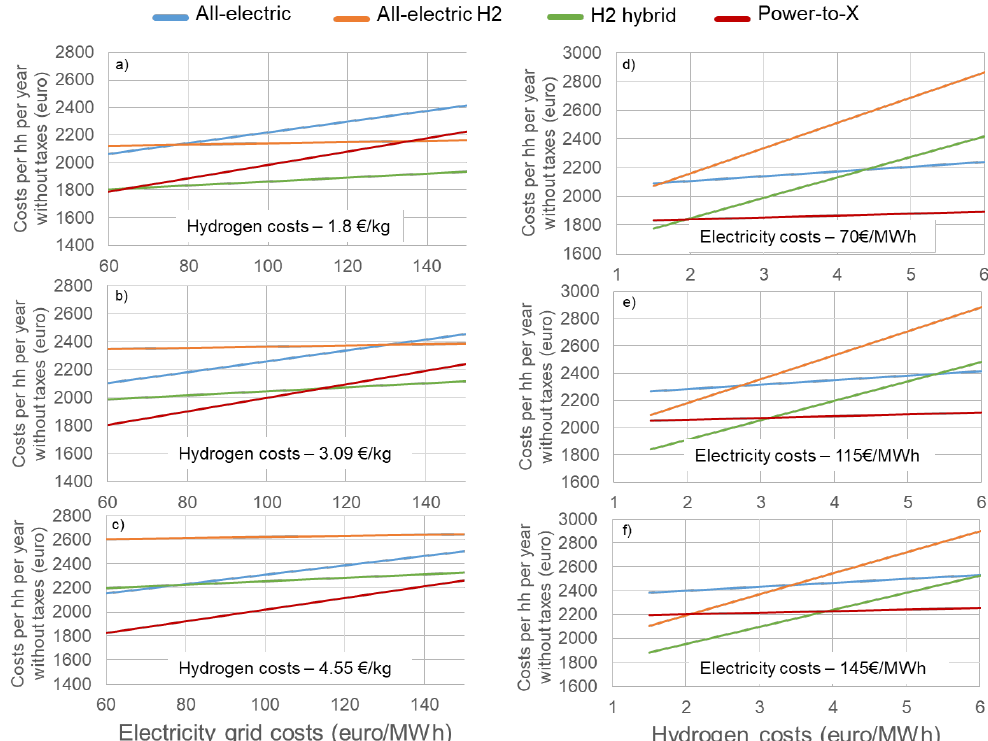
Figure 16. Sensitivity analysis on electricity costs (import from the grid) and hydrogen import costs. The left side shows the sensitivity of the yearly costs per household to the electricity price for climate-neutral electricity, with a fixed hydrogen price in the low ( a ), middle ( b ) and high ( c ) range. The right side shows the sensitivity of the yearly costs per household to the hydrogen costs, with a fixed electricity costs price in the low ( d ), middle ( e ) and high ( f ) range. The middle range values are the values used for the economic analysis in this paper. The analysis shows that the lowest costs option is either the H 2 hybrid system or power-to-X, which are the systems with the most conversion and storage mechanisms and diversification of energy carriers in the households.